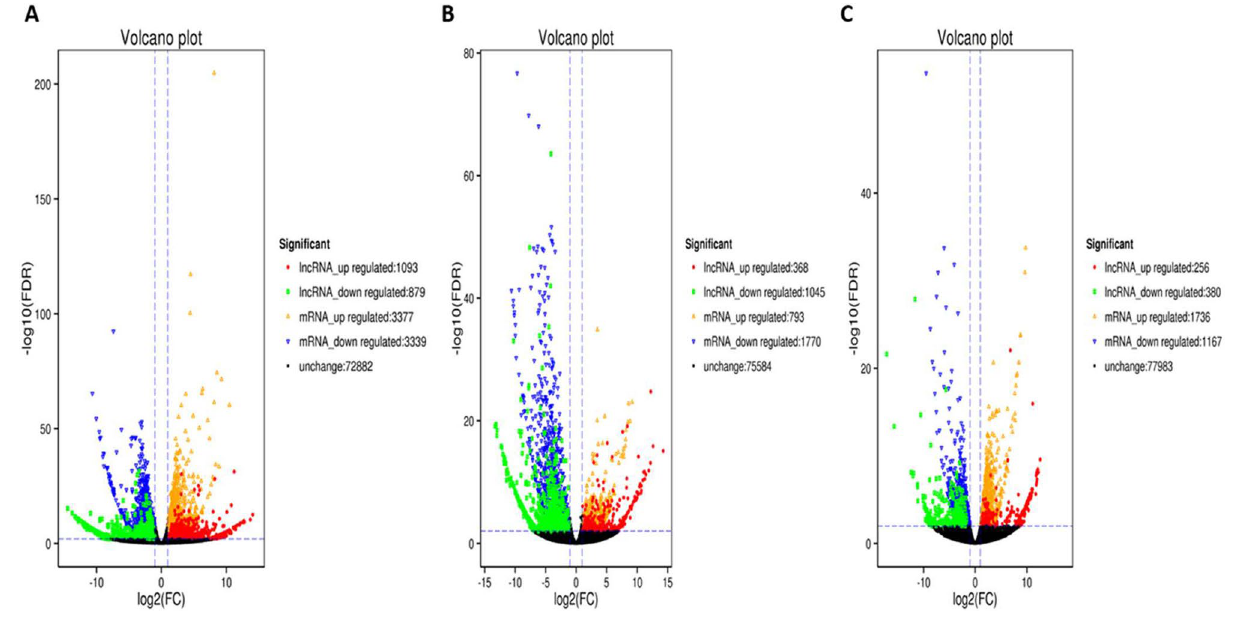
Figure 1. Volcano plots showing the distribution of differentially expressed long non-coding RNAs (lncRNAs) and messenger RNAs (mRNAs) in ovarian tissues in Hu sheep. ( A ) H1 vs H3, ( B ) H1 vs H8 and ( C ) H3 vs H8.